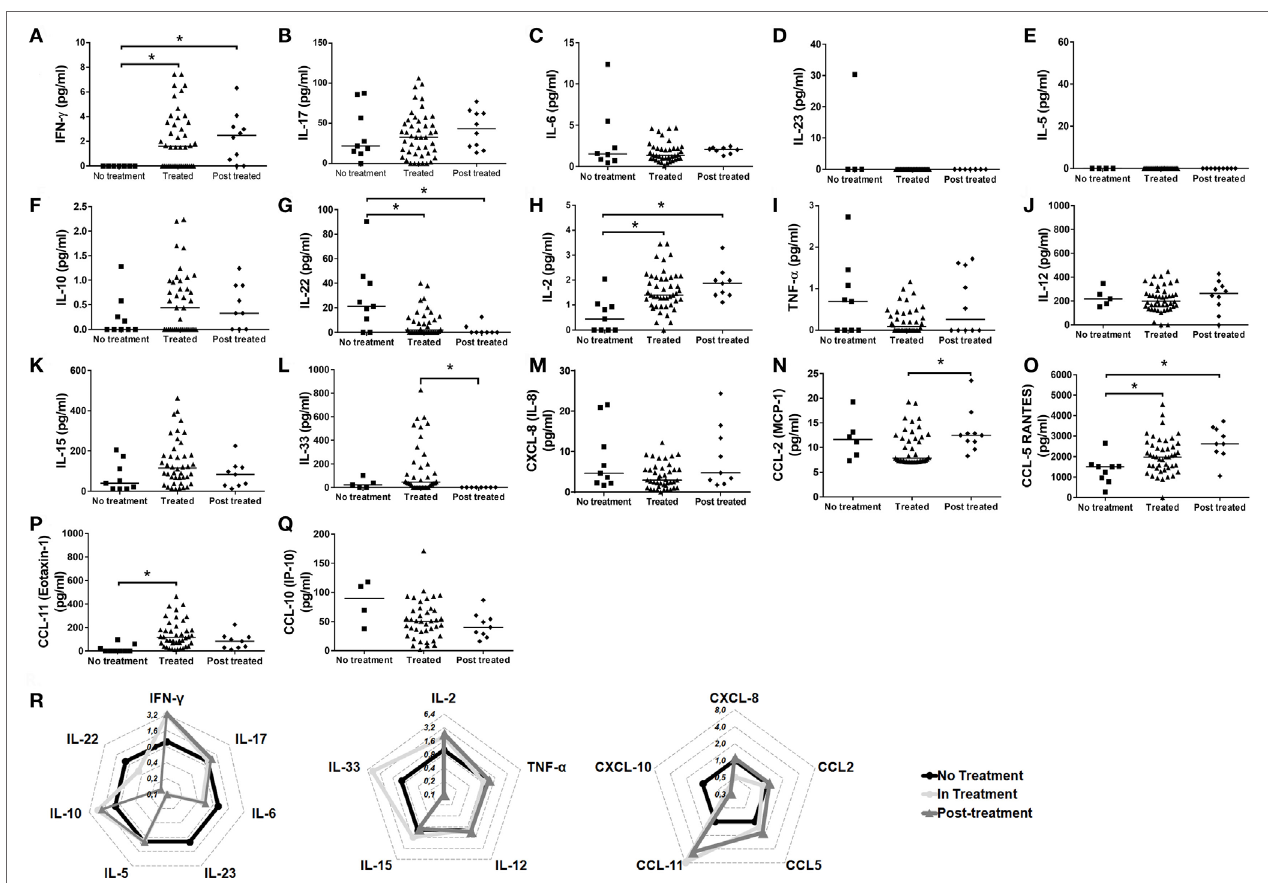
FigUre 4 | Cytokine and chemokine interplay after treatment with immunosuppressant drugs. Levels of (a) IFN- γ , (b) IL-17, (c) IL-6, (D) IL-23, (e) IL-5, (F) IL-10, (g) IL-22, (h) IL-2, (i) TNF- α , (J) IL-12, (K) IL-15, (l) IL-33, (M) CXCL-8/IL-8, (n) CCL-2/MCP-1, (O) CCL-5/RANTES, (P) CCL-11/eotaxin-1, and (Q) CXCL-10/ IP-10 from patients with the endemic form (fogo selvagem—FS) of pemphigus foliaceus under different conditions of treatment (no treatment, treated, and post-treatment). Lines represent median. * p < 0.05, Kruskal–Wallis test followed by Dunn’s test. (r) Radar plot representation of serum cytokine and chemokine profile of not treated (black lines), in treatment (light gray) and post-treatment (dark gray) FS patients. Data were obtained by calculating the ratio between the median concentrations of each cytokine in the pemphigus foliaceus (FS) patients under- or post-treatment versus the untreated